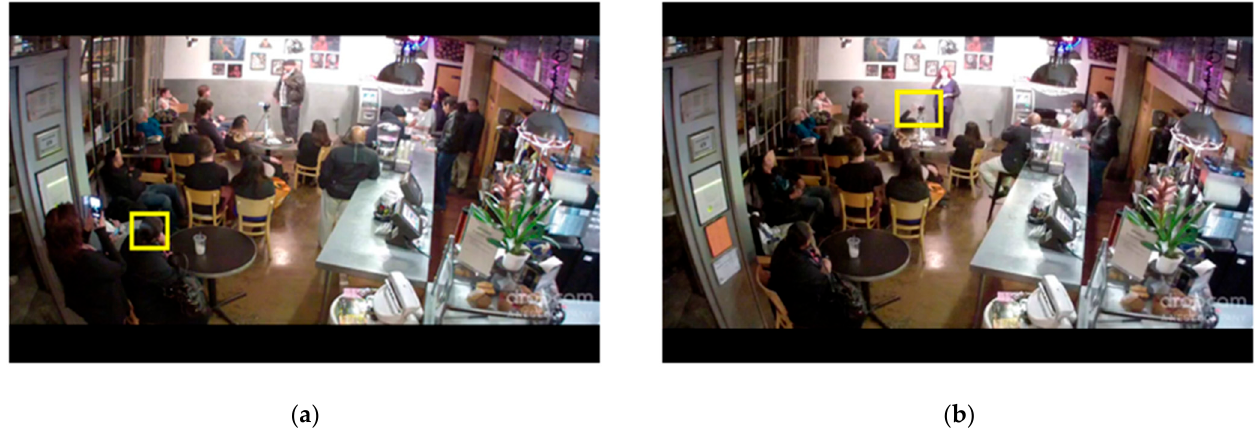
Figure 8. Original drawing of brainwash dataset: ( a ) test image with 18 people; ( b ) test image with 16 people.